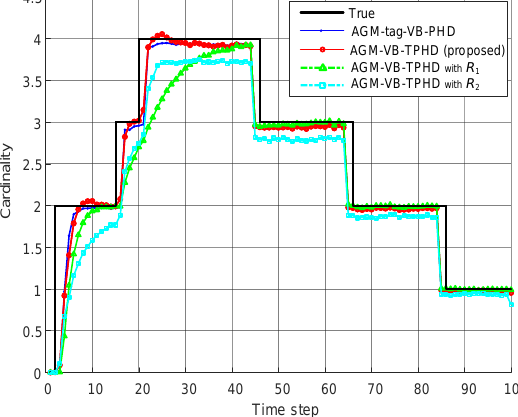
Figure 3. The average cardinalities of different filters.